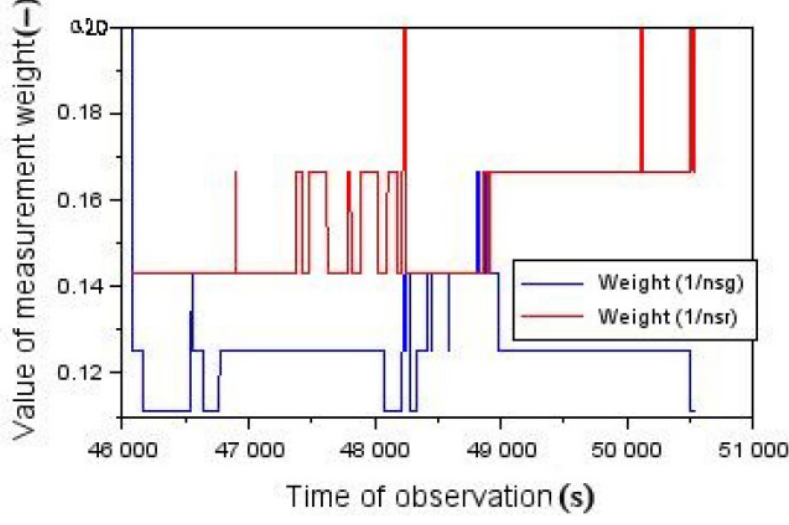
= P g ; b = d = f = 1 ns g